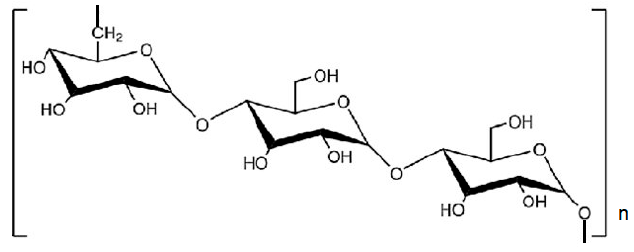
Figure 14. Chemical structure of pullulan.